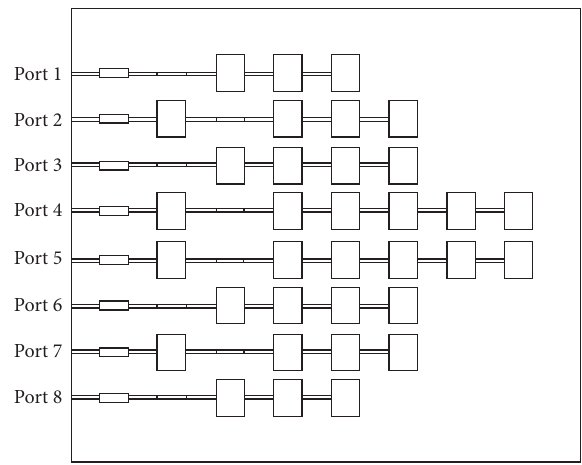
Figure 13: Ports setup for proposed 34 elements thinned array antenna.